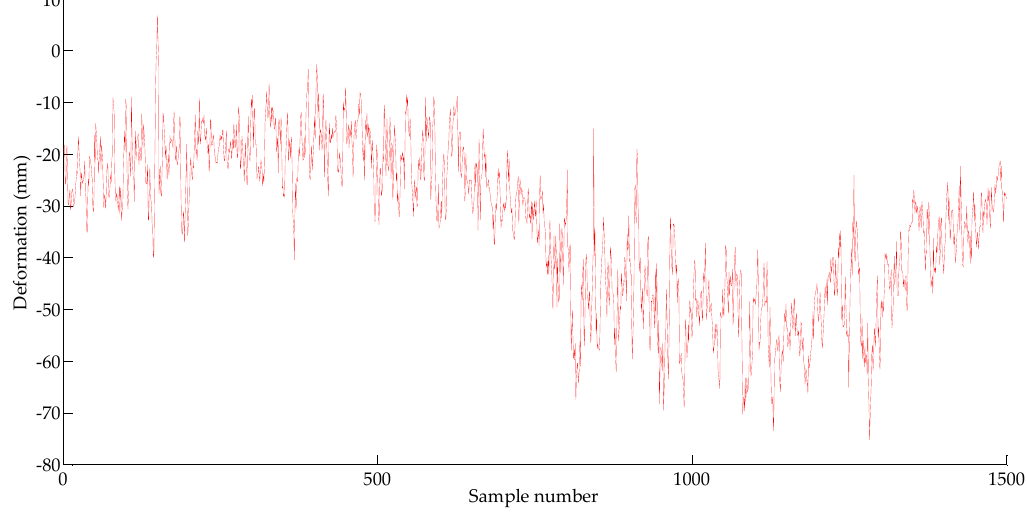
Figure 7. Deformation time series {X 2t }.